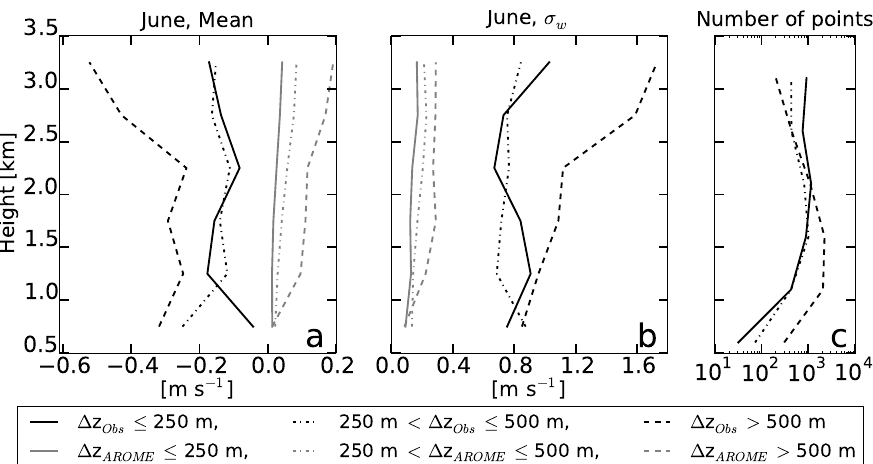
Fig. 6. Observed (black) and modelled (grey) vertical velocity distribution parameters at SGP in June for clouds classified by their geometrical thickness ( 1z ) (solid lines for 1z ≤ 250m, dash-dot lines for 250 <1z ≤ 500m and dashed lines for 1z ≥ 500m). (a) mean vertical velocity, (b) standard deviation ( σ w ), (c) number of points for the observations (for AROME, the number of points is larger for all cases, while the shapes of the profiles are qualitatively rather similar).